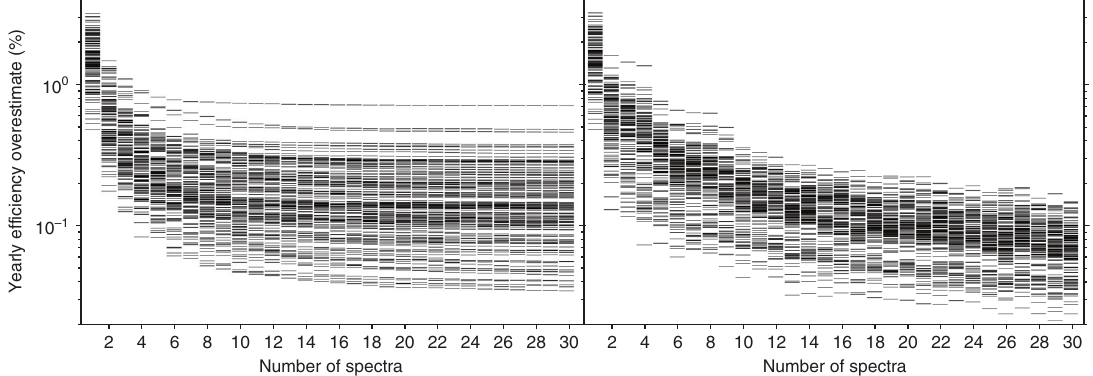
Fig. 3 Validation and convergence. Scatter plots of the yearly averaged ef fi ciency overestimate as a function of the number of proxy spectra. The data correspond to a set of random, but near optimal (within 2% of the maximum ef fi ciency), series connecting six-junction devices. a Binning